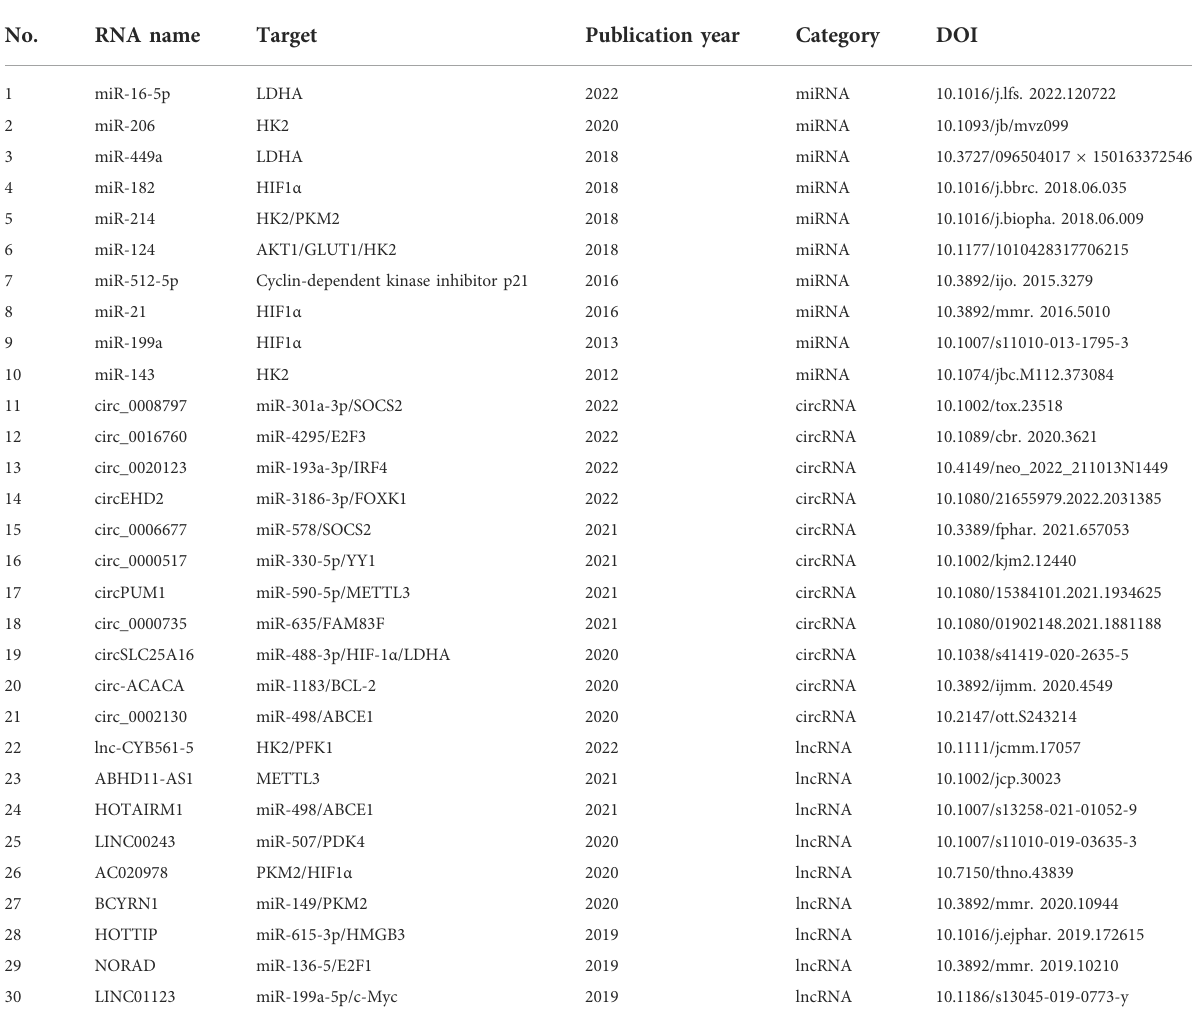
TABLE 3 Non-coding RNAs targeting glycolysis in NSCLC.